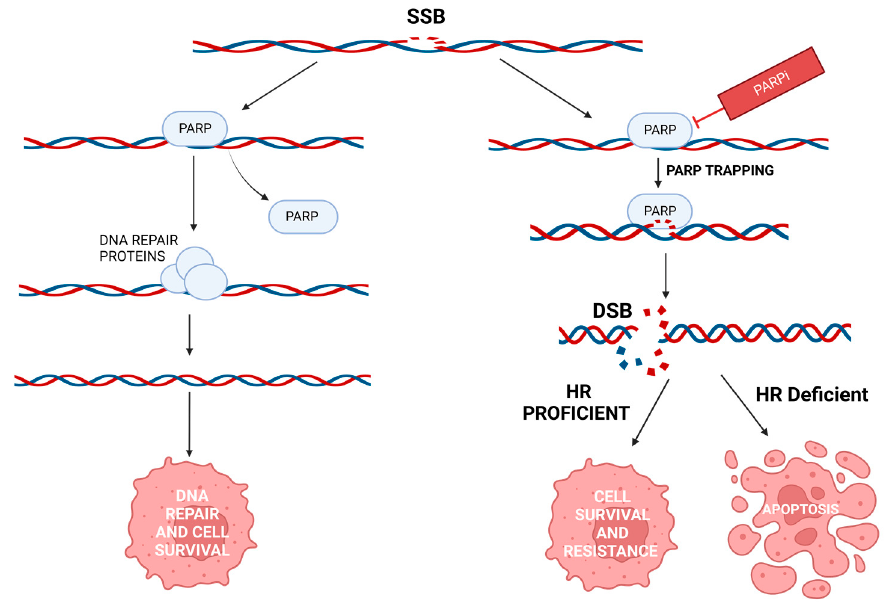
Figure 5. The effects of PARP binding after single-stranded DNA breaks. The binding of PARP1 helps detect the single-stranded break (SSB) and promotes the base excision repair (BER) mechanism for DNA repair. PARP must be released from the DNA for the repair to occur. When treated with PARP inhibitors (PARPi), PARP trapping occurs, leading to double-stranded breaks (DSB). When homologous recombination (HR) occurs, the DNA is repaired, and cell survival occurs. Created with BioRender.com.